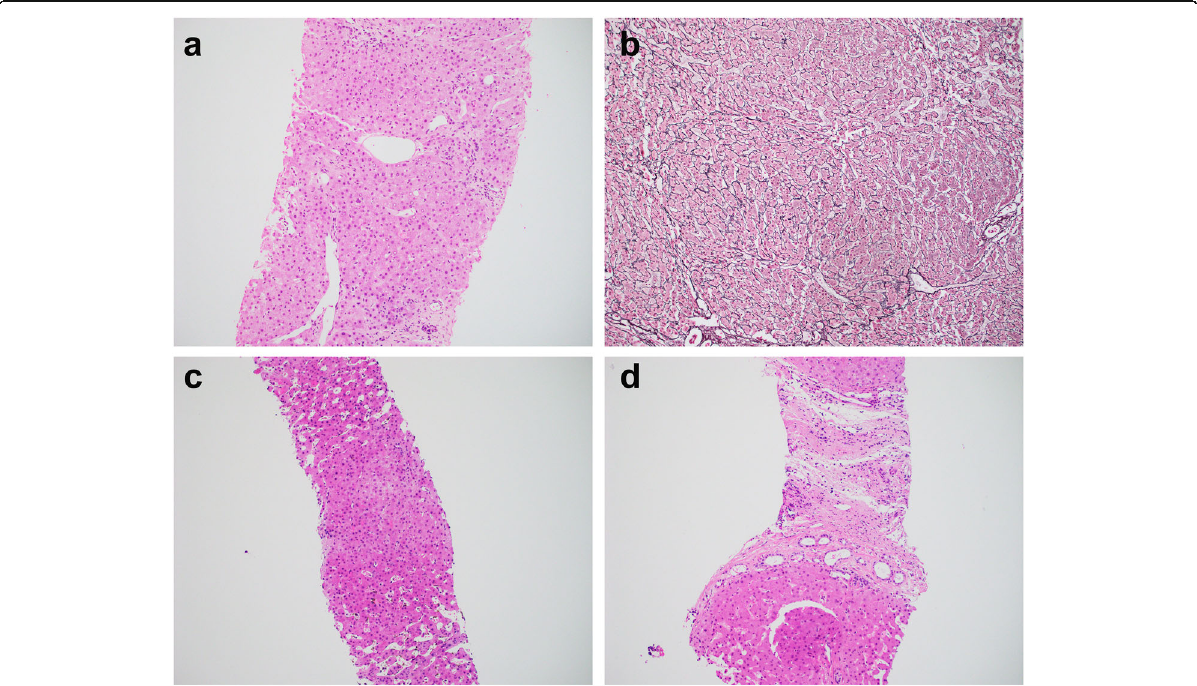
Fig. 2 Mimics of CHF with histologic features of hepatoportal sclerosis. a-b Case 15. Biopsy ( a ) showing portal vein abnormalities with alternating obliteration/hypoplasia in some portal tracts, but dilation and herniation in other portal tracts. Reticulin stain in explant liver ( b ) confirms nodular regenerative hyperplasia. c Case 17. Sinusoidal dilatation with Kupffer cell hyperplasia and iron deposit. d Case 19. Focal and mild bile duct abnormalities that mimics ductal plate malformation. Magnification: